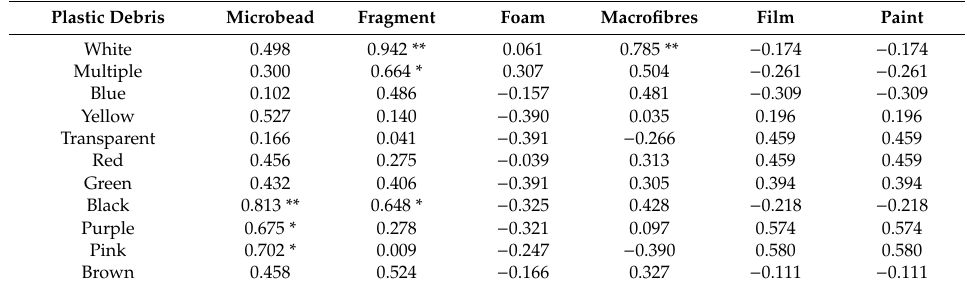
Figure 5. Amount of particles of plastic debris by color along the land-based wastewater on both sides of the beach. Table 2. Spearman correlation coefficients between the amount of plastic debris by color and composition (n = 10).